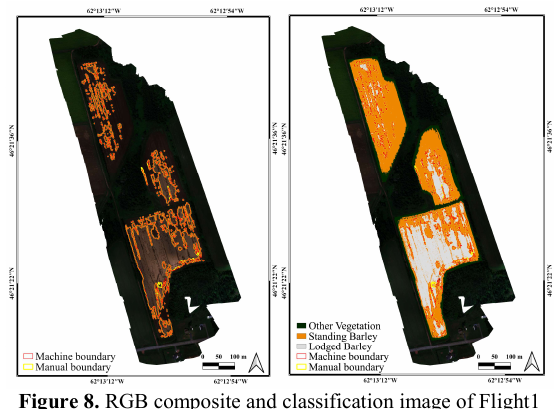
Figure 8. RGB composite and classification image of Flight1 barley fields with the lodging delineation results